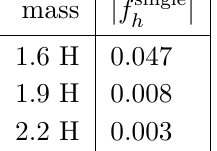
Table 2 . NG mediated by h via single exchange diagram in single-(cid:12)eld slow-roll in(cid:13)ation.